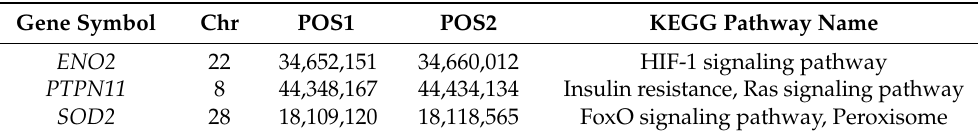
Table 3. Overlapping genes associated with reproductive traits in twin colt group based on both joint